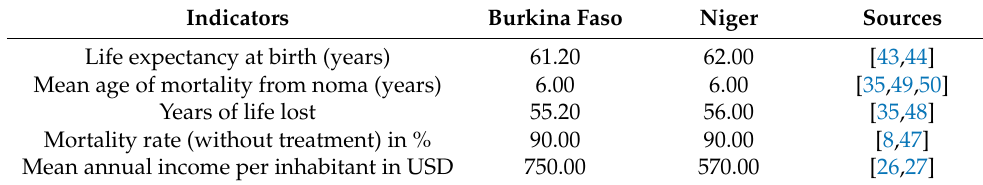
Table 3. Socio-economic indicators for Burkina Faso and Niger in